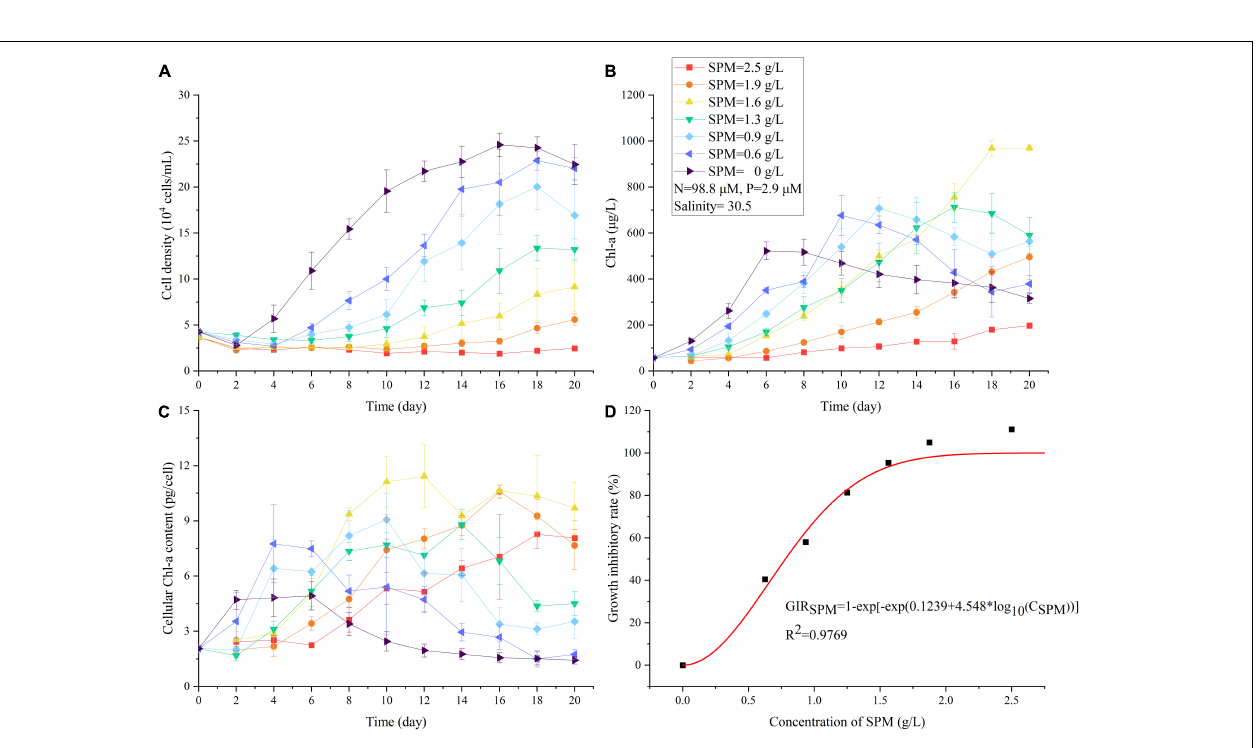
Frontiers in Marine Science |